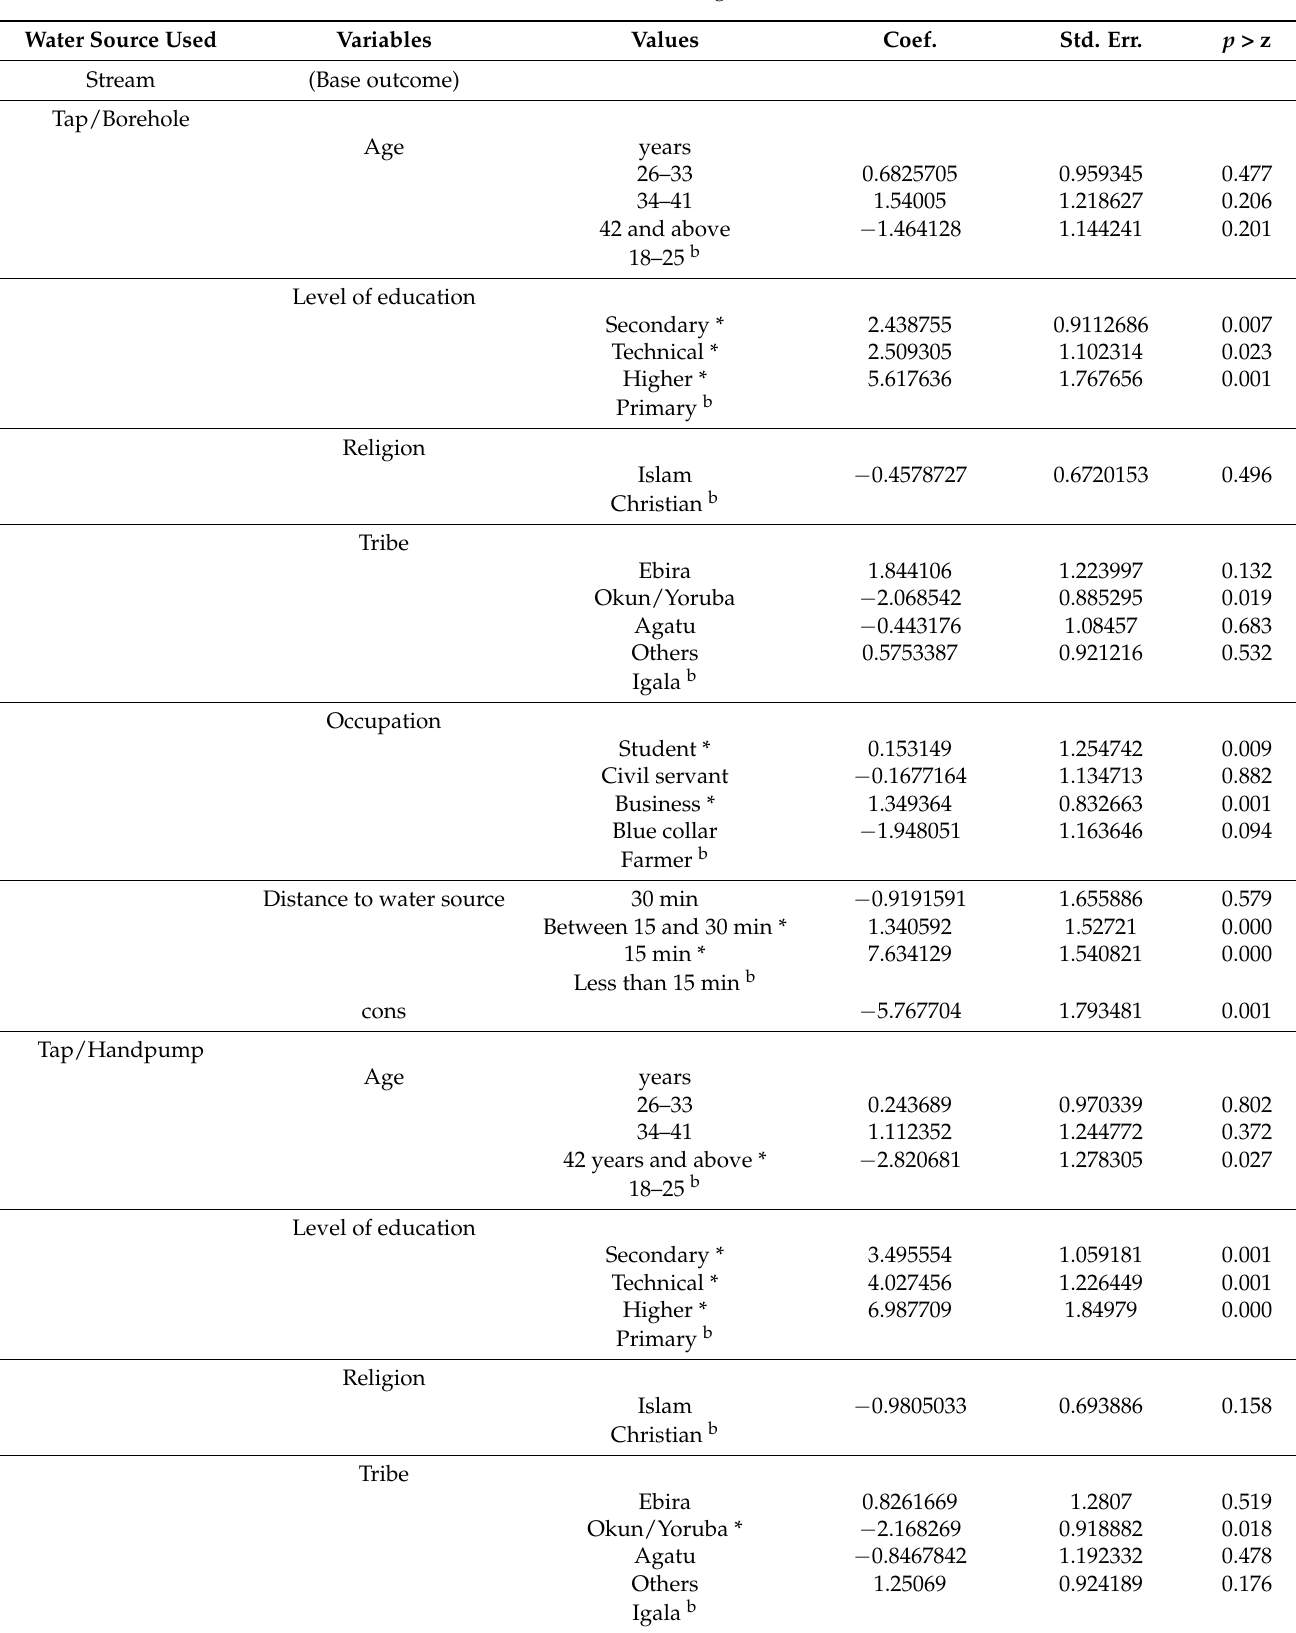
Table A2. Multinomial logistic